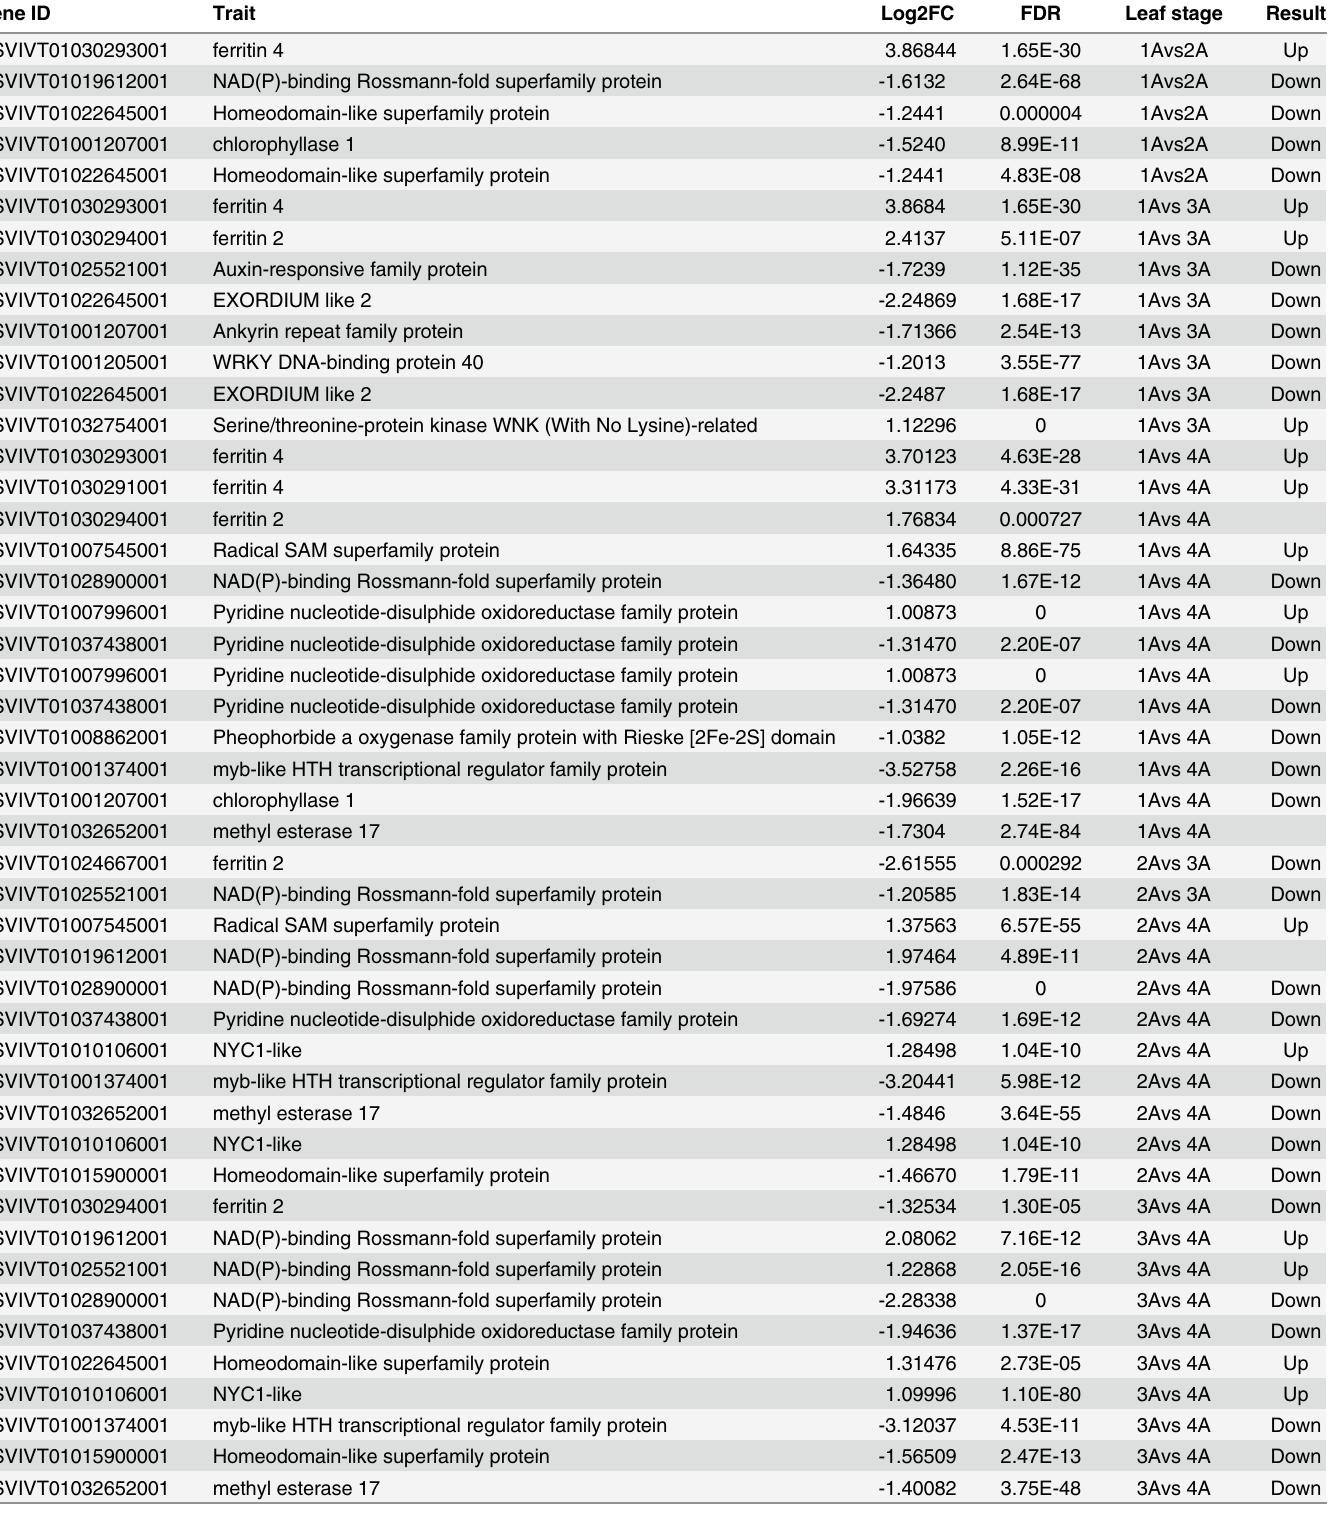
Table 3. Differential expressed genes, related to Porphyrin and chlorophyll